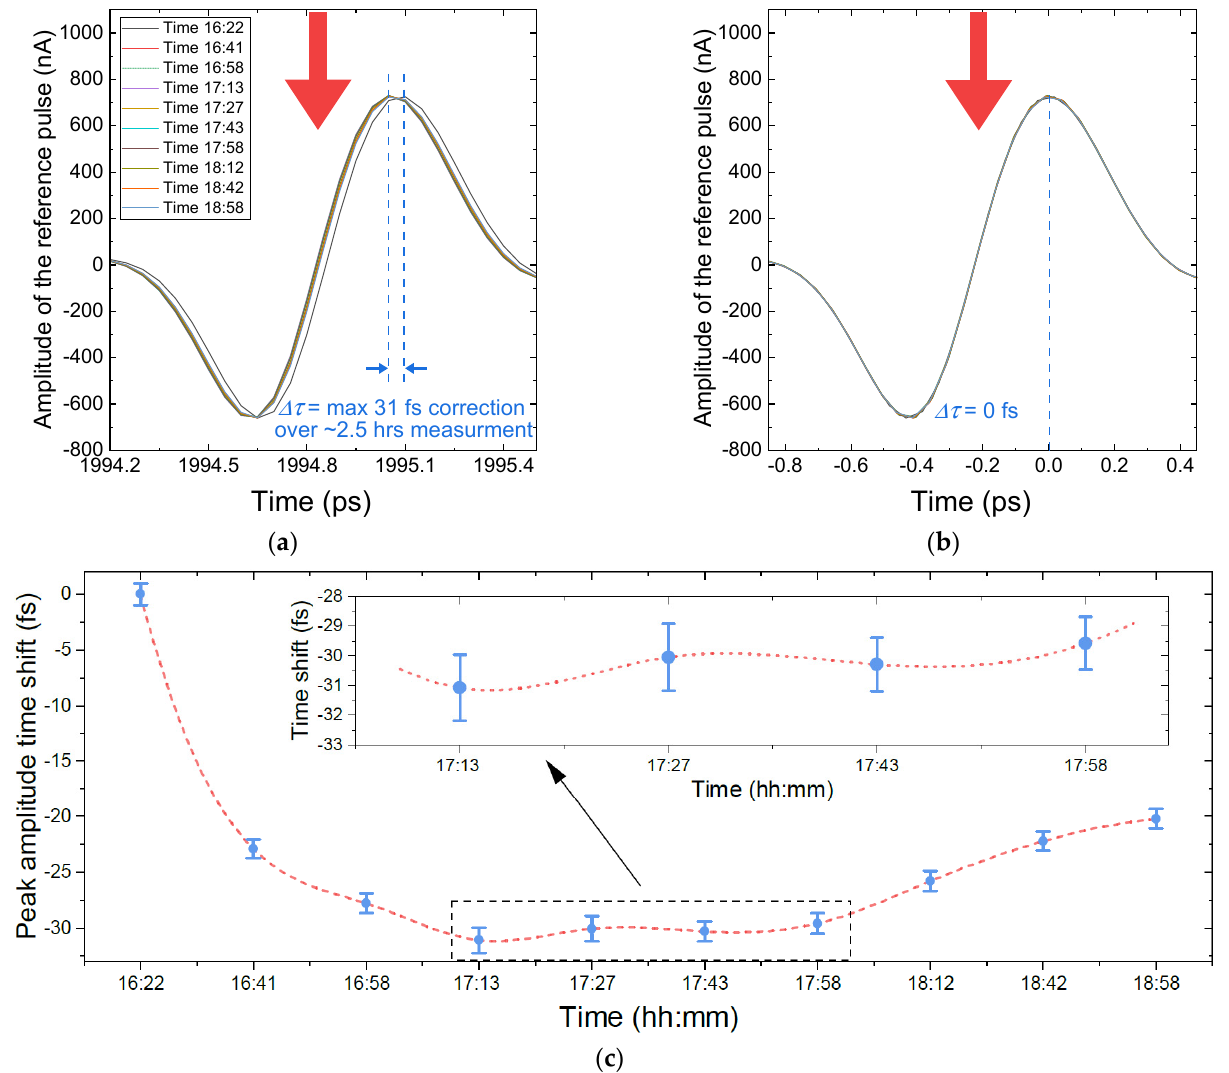
Figure 6. Time correction procedure of the THz pulse: ( a ) Actually measured waveforms of the reference pulse before correction; ( b ) The same waveforms brought to the common “zero delay” time after correction. The applied correction is also valid for the pulses propagating through gasoline samples during the measurements. The color code of the arrows above the pulses is used consistently with previous figures; ( c ) The measured evolution of the peak amplitude of the THz reference pulse during approx. 2.5 h-long series of the measurements. The positions of the peaks with fit errors were determined by numerical fit with a predefined function. The inset of the graph shows small-scale oscillations of the pulse position in detail.